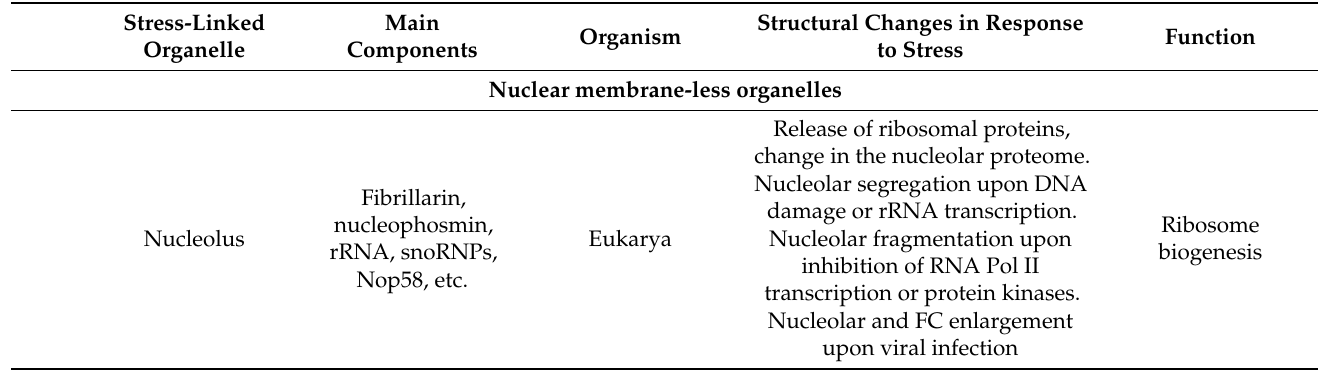
Table 1. Examples of LLPS (or suggested to be LLPS) compartments formed or rearranged in response to stress in eukaryotic